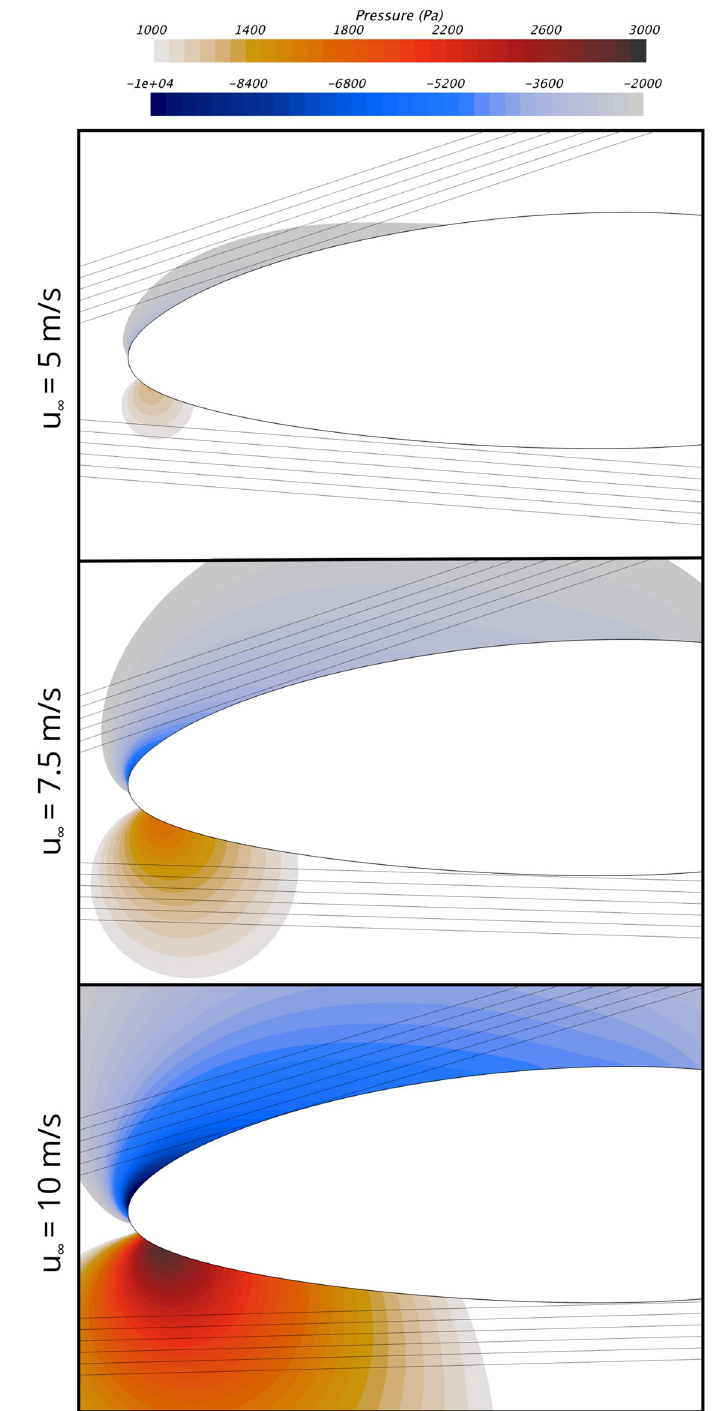
Fig 8. Bat flight paths by the 90% blade span location of the NREL 5 MW reference turbine from the upwind and downwind direction when the turbine is operating at wind speeds of 5 m/s, 7.5 m/s, and 10 m/s. Note that only the front section of the blade is shown and that the flight paths are for a bat flight speed of 10 m/s, with respect to the oncoming wind direction. For scale, note that the bat flight paths are separated by 20 mm in the direction normal to the flight